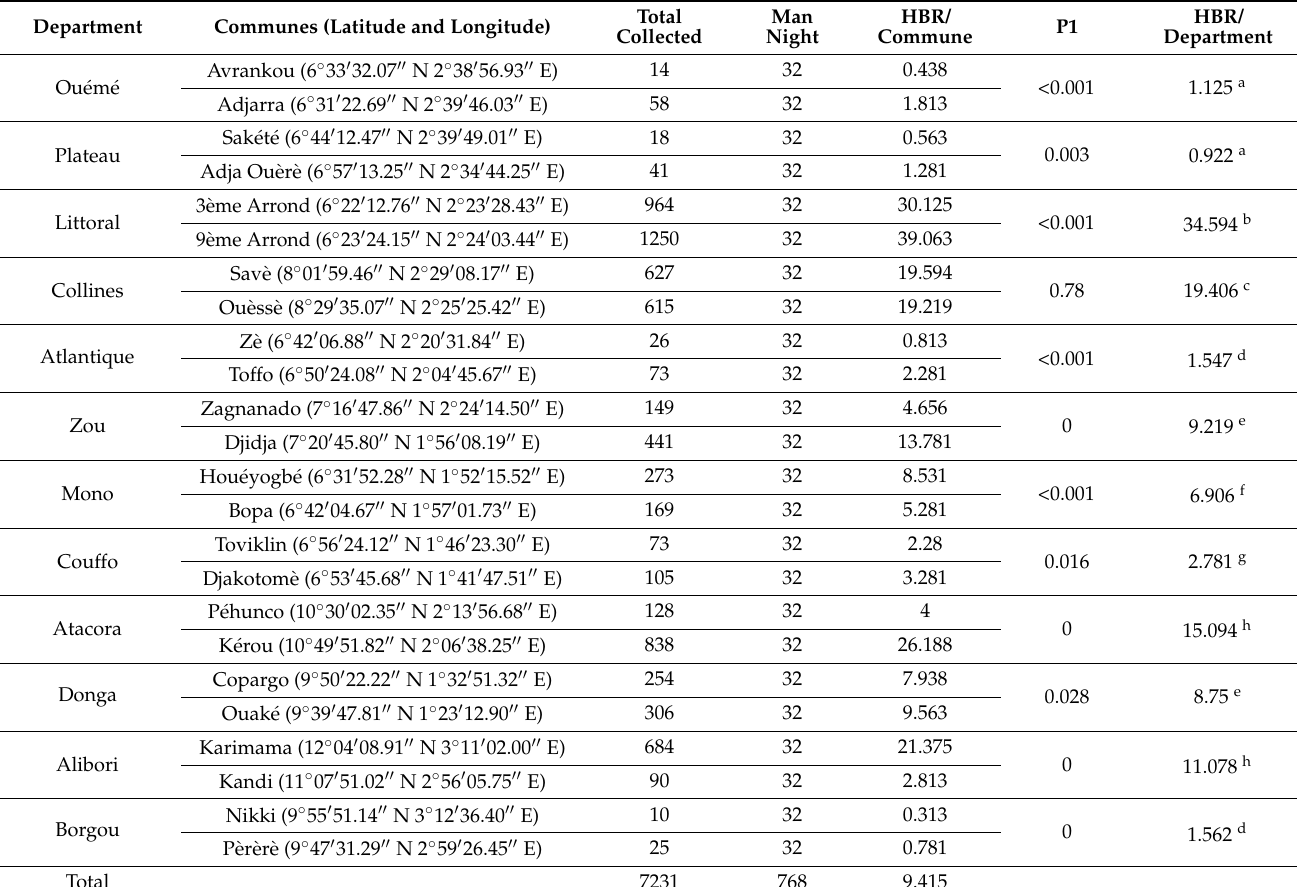
Table 1. Bite rate per man per night (HBR) by commune and